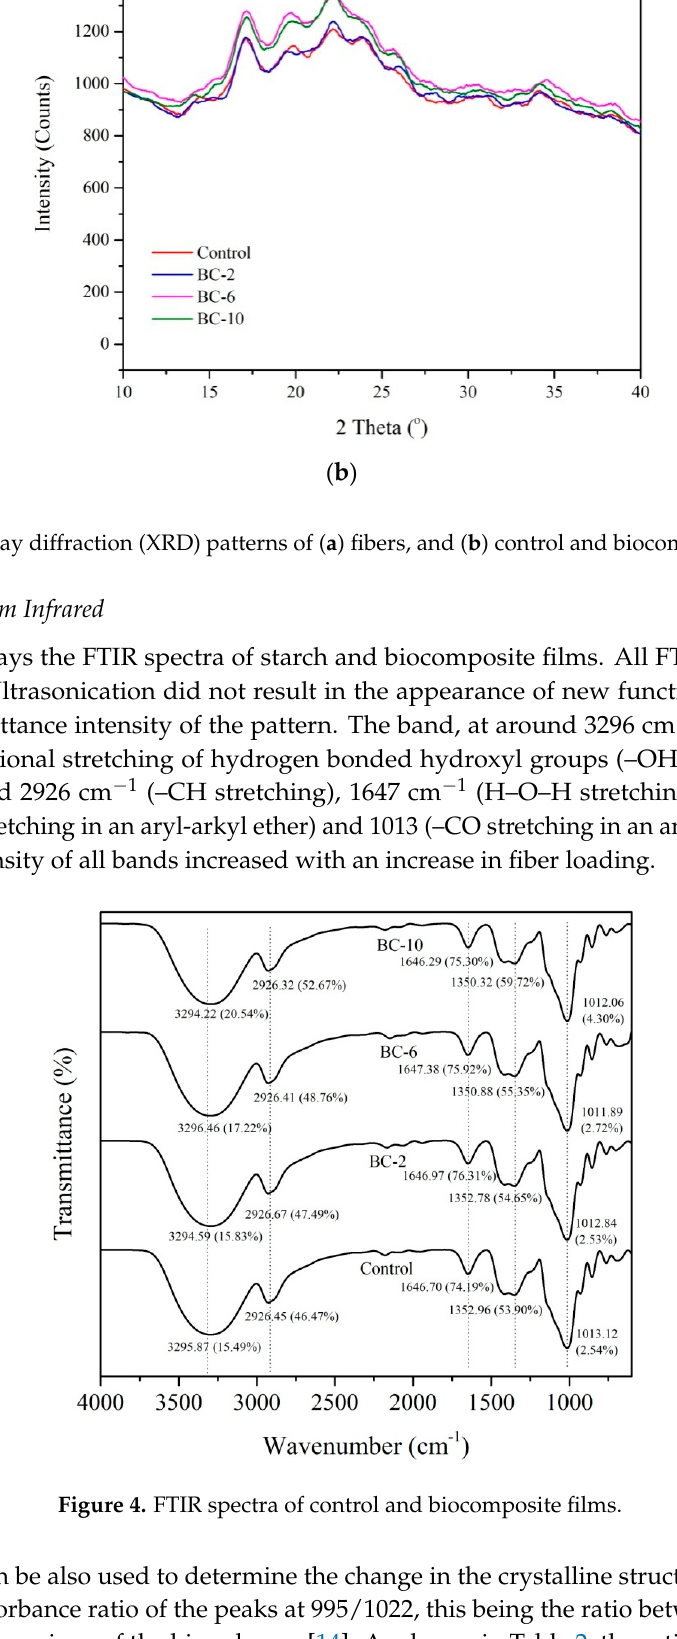
Figure 4. FTIR spectra of control and biocomposite films.